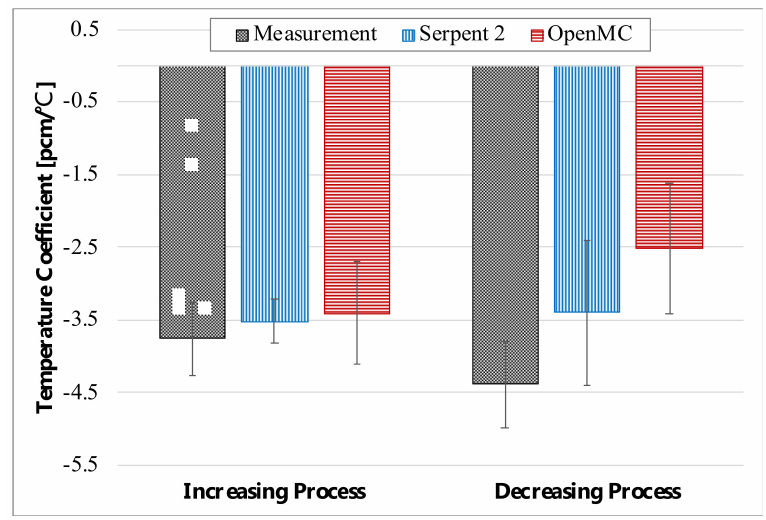
Figure 14. Results of temperature coefficients.